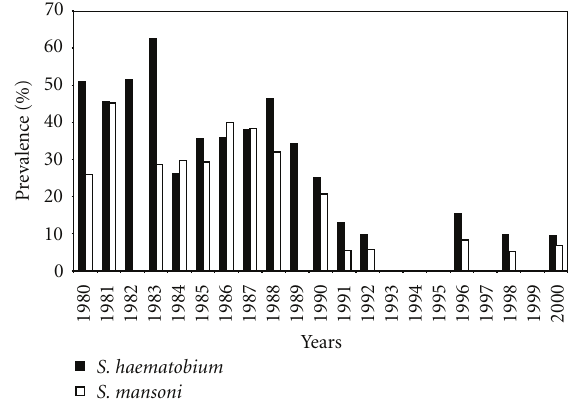
Figure 4: Prevalences of Schistosoma haematobium and S. mansoni among school children in Hippo Valley Estates for the period 1980– 2000